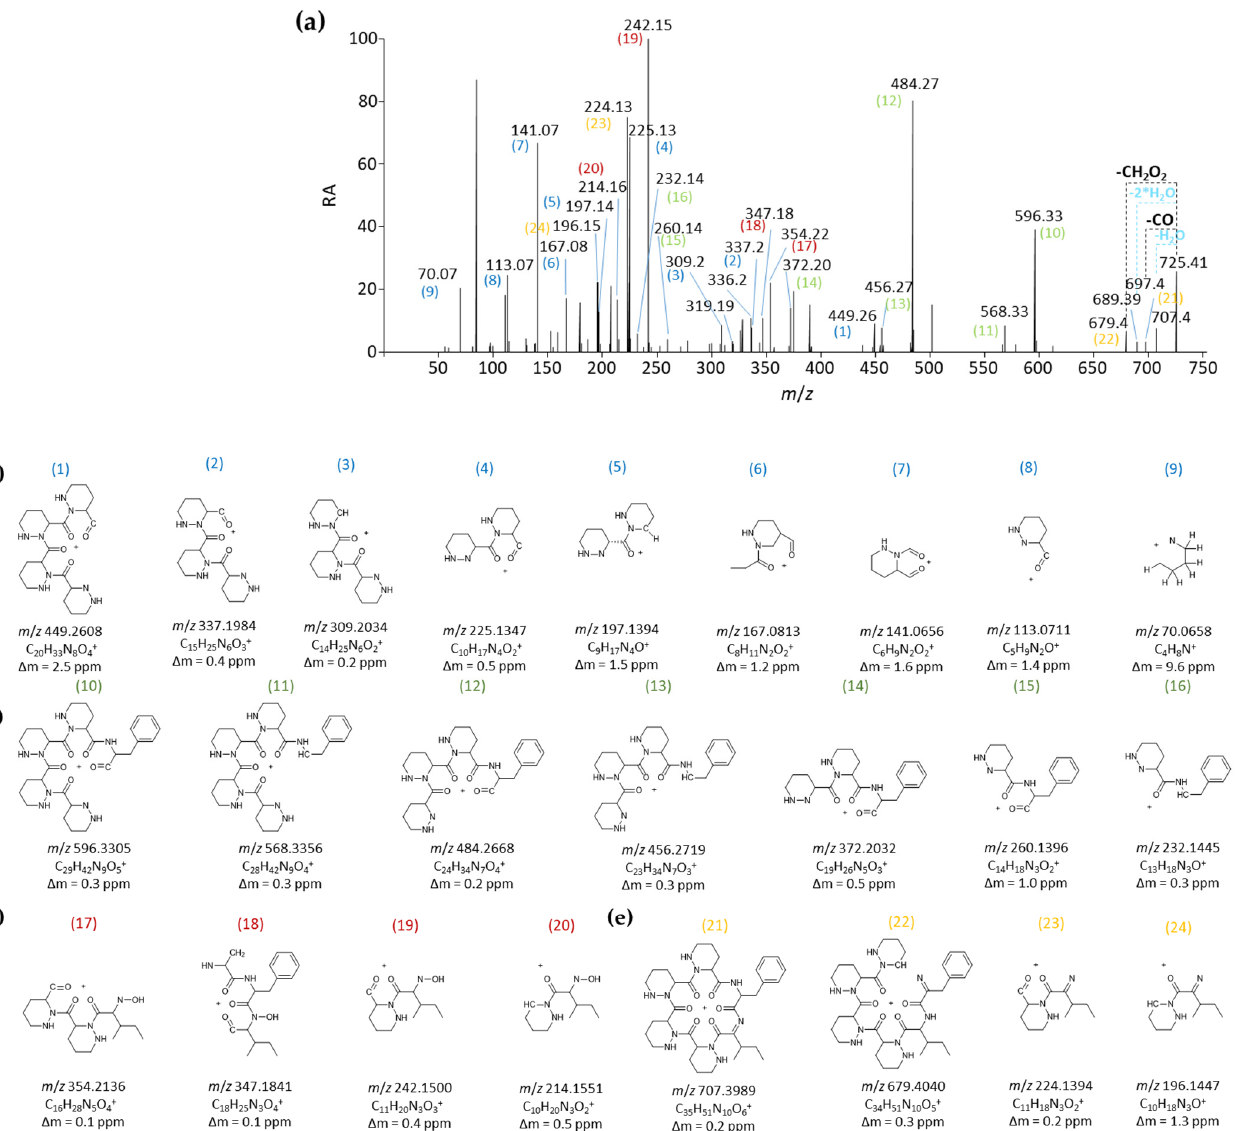
Figure 4. HRMS/MS-based identification of fragmentation patterns of compound 1 . ( a ) MS fragmen- tation spectrum. ( b ) Structure of ions containing one to four Piz residues (these ions are highlighted by numbers in blue in the MS fragmentation spectrum). ( c ) Structure of fragment ions containing the phenylalanine building block (these ions are highlighted by numbers in green in the MS fragmenta- tion spectrum. ( d ) Structure of fragment ions that contain a hydroxyl-isoleucine residue (these ions are highlighted by numbers in red in the MS fragmentation spectrum). ( e ) Structure of fragment ions seemingly resulting from the neutral loss of H 2 O further supporting the presence of hydroxylated isoleucine (these ions are highlighted by numbers in orange in the MS fragmentation